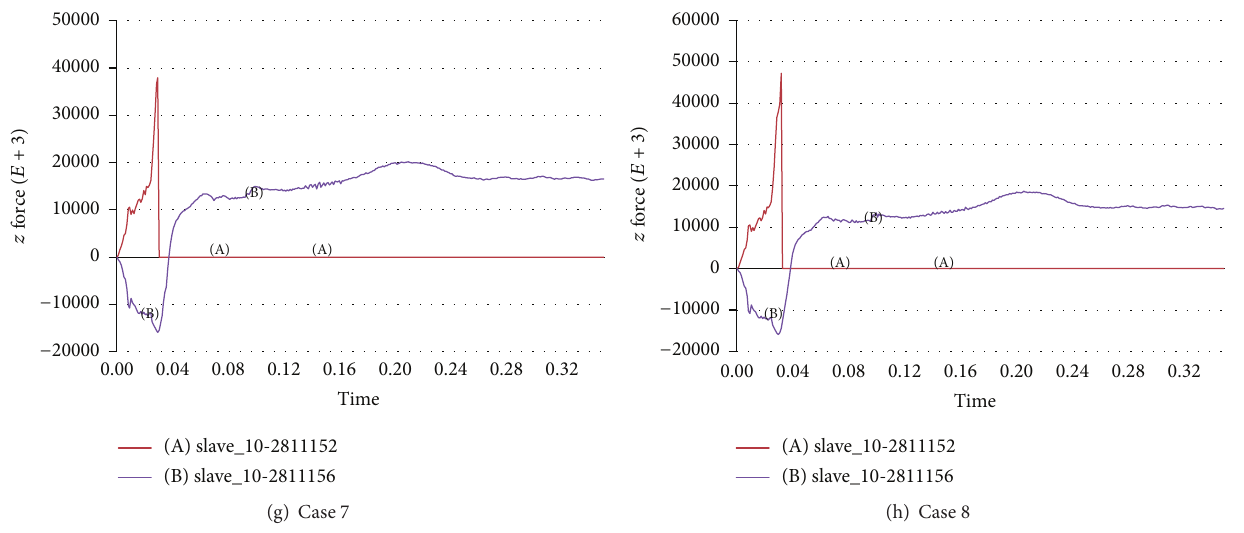
Figure 12: Induced vertical forces in the 𝑧 -axis at the point of failure force measurement (cases 1 ∼ 8).